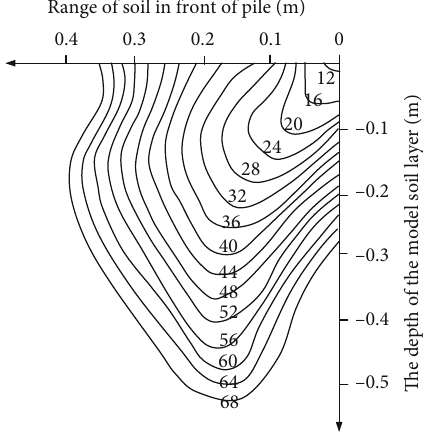
Figure 18: Isolate map of plastic zone in front of pile under di ff erent loads.